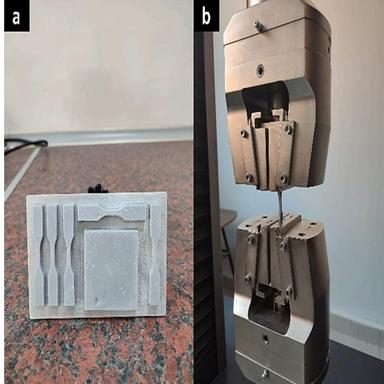
Macro view of (a) tensile and density samples and (b) used tensile test apparatus.